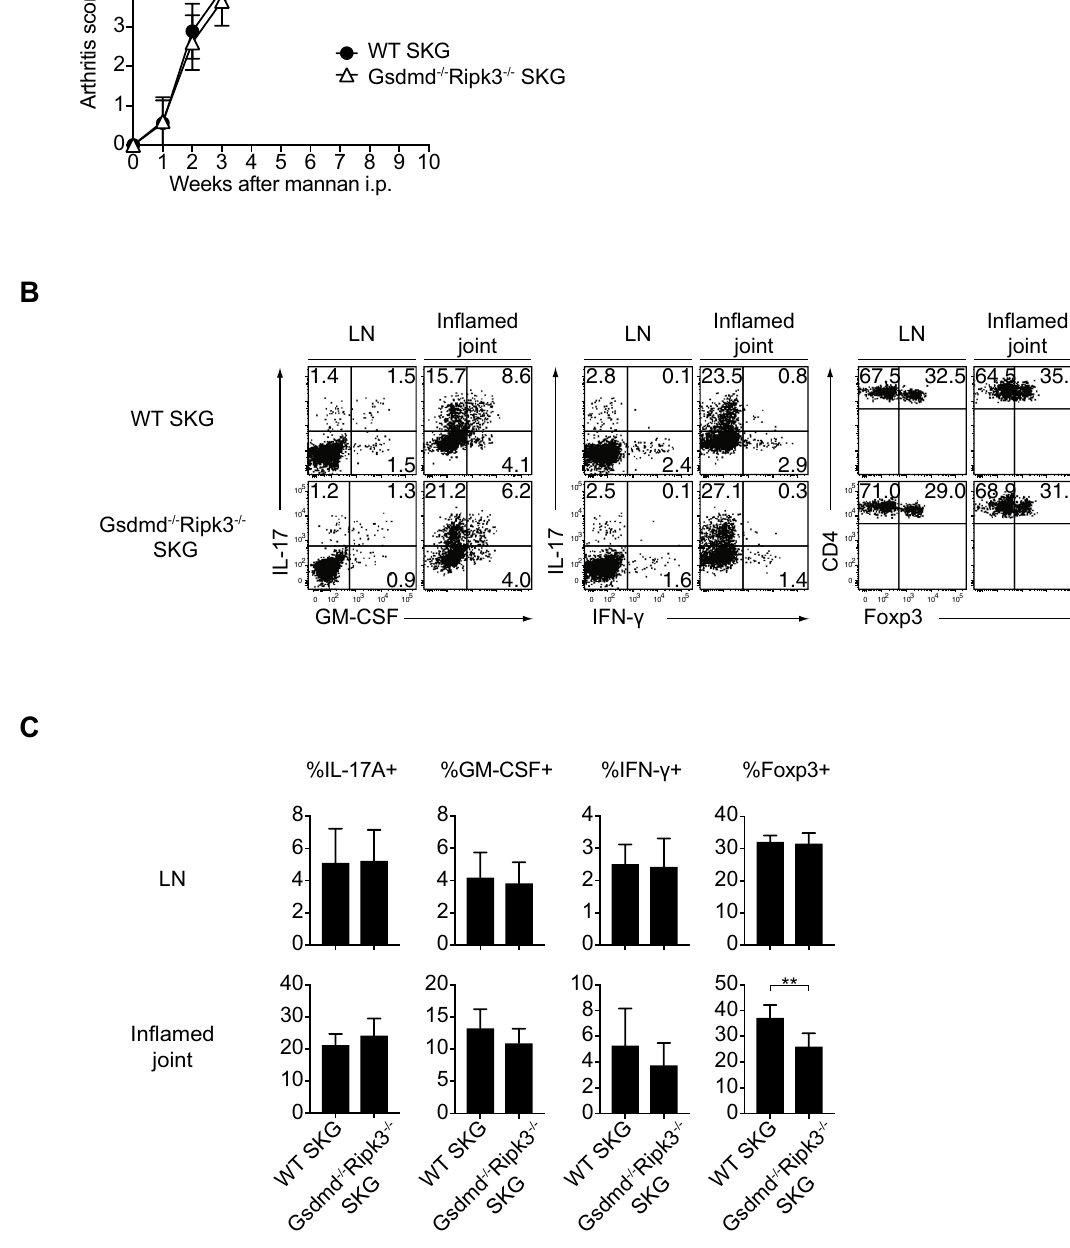
Figure 5. The dispensable role of crosstalk between Gsdmd and Ripk3 in the development of autoimmune arthritis. ( A ) Arthritis scores of WT (n = 9) and Gsdmd −/− Ripk3 −/− SKG mice (n = 10) after the injection of mannan (20 mg). ( B , C ) Flow cytometry of IL-17A + , GM-CSF + , IFN-γ + and Foxp3 + cells in CD4 + T cells in draining LNs and inflamed joints of WT (n = 9) and Gsdmd −/− Ripk3 −/− SKG mice (n = 10). The vertical bars denote the SD in panel ( C ) and the SEM in ( A ). ** P < 0.01. Data are pooled from two independent experiments in panels ( A , C)